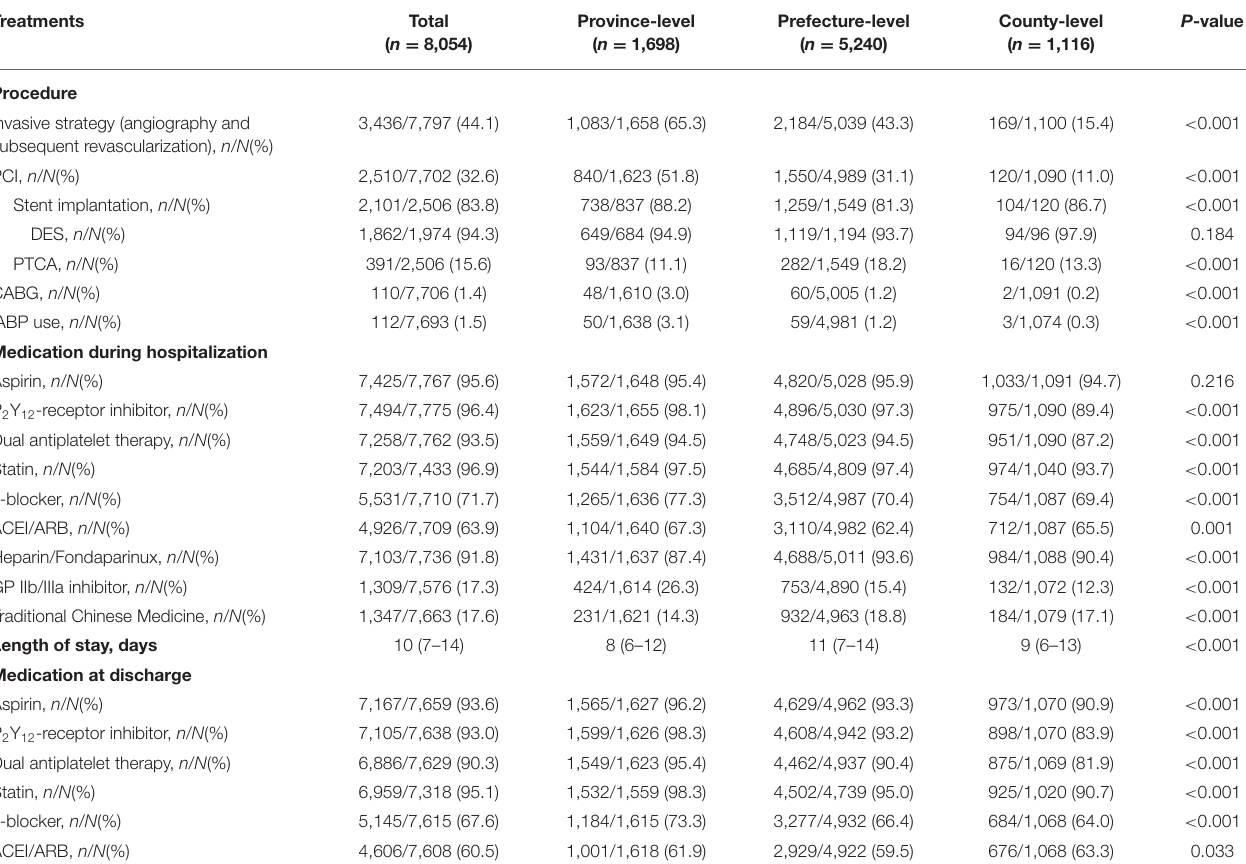
TABLE 2 | Treatments for patients with NSTEMI among the three hospital levels. Treatments Total